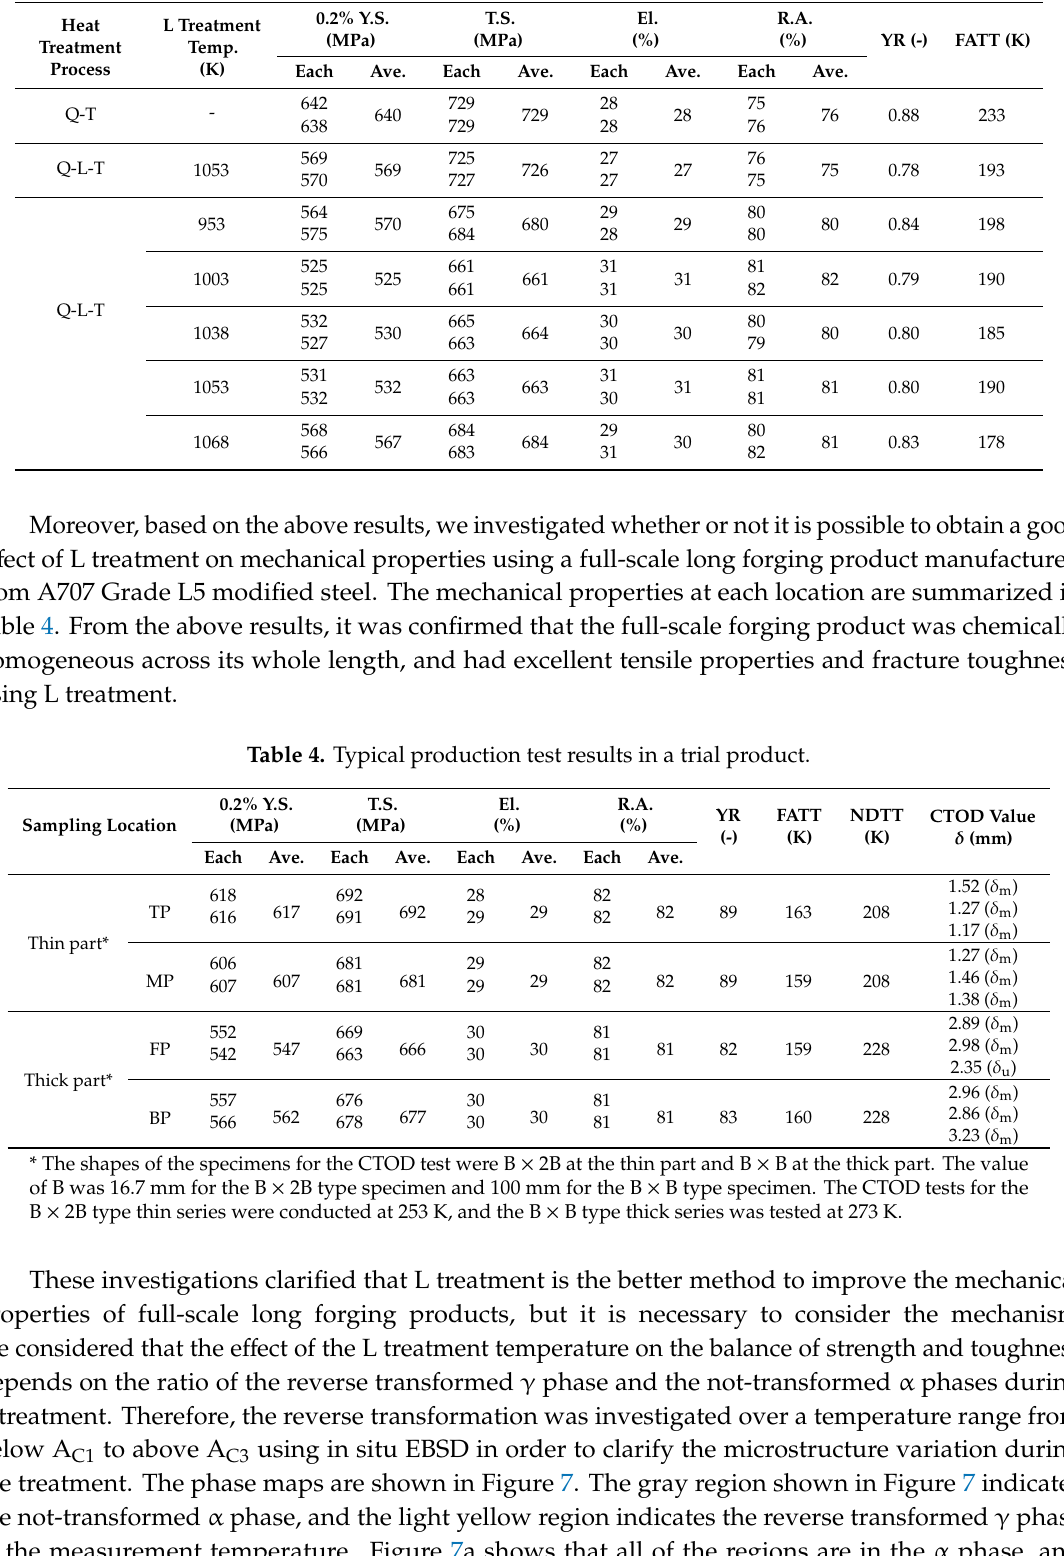
Table 3. Summary of the mechanical test data of the Q–T sample and Q–L–T samples obtained at various L temperatures.